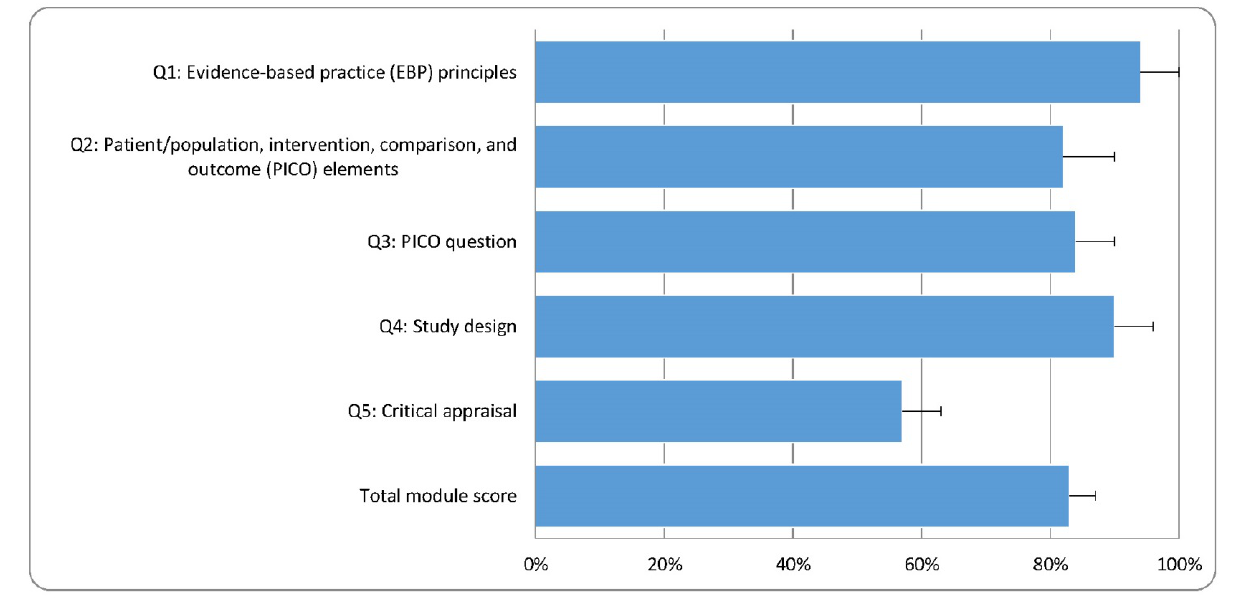
* Data are presented as means (95%